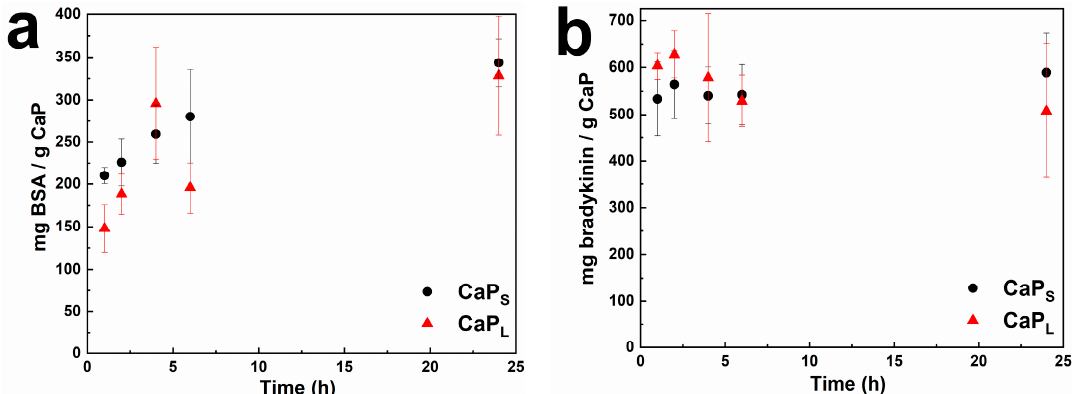
Figure 2. Effect of incubation time on the loading capacity of CaP S and CaP L nanoparticles for ( a ) bovine serum albumin (BSA); and ( b ) bradykinin (pH 7.4, particle concentration 500 μ g/mL, BSA/bradykinin concentration 500 μ g/mL). Both BSA and bradykinin rapidly adsorb on the nanoparticles’ surface during the first hour.